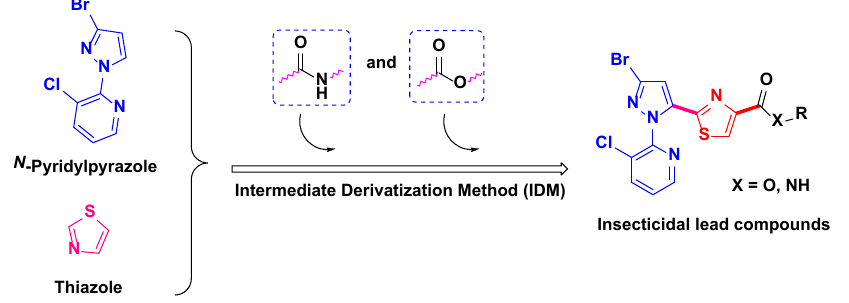
Figure 2. Design strategy and structure optimization of insecticidal molecules.